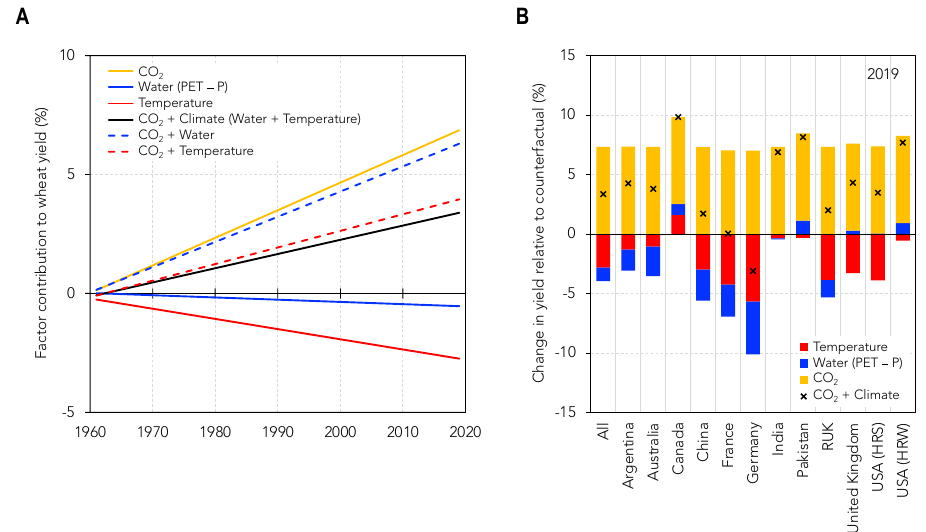
Figure 2. Climate and [CO 2 ] contributions to variations in wheat yield. ( A ) Percent change in wheat yield calculated as the relative difference between the original regression model and the model with values for temperature (red solid line), water deficit (blue solid line), [CO 2 ] (yellow solid line), and all three combined (temperature, water deficit, and [CO 2 ]; black solid line) fixed at 1961–1965 levels. The graph is presented as the relative contribution of each of the variables to the change in wheat yield. The contribution of the combinations: temperature + [CO 2 ] and water deficit + [CO 2 ] are also presented as red and blue dashed lines, respectively. ( B ) The separate contribution of temperature (red bars), water deficit (blue bars), and [CO 2 ] (yellow bars) to the change in wheat yield in 2018–19 compared with the baseline of 1961–1965 for each of the top 12 global wheat producers. The total contribution of both climate and [CO 2 ] is noted with an “x”